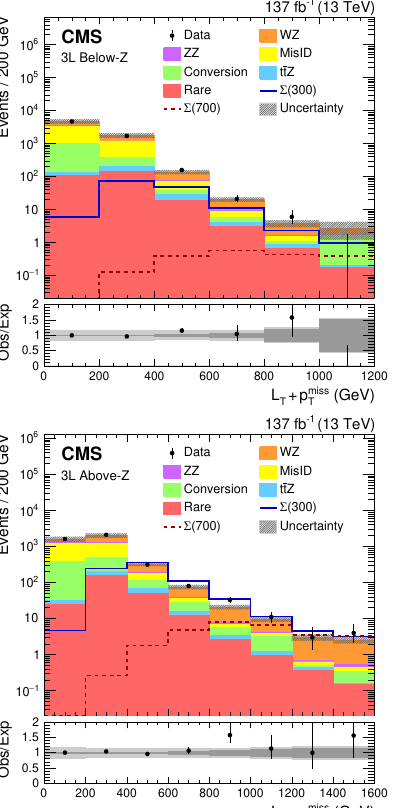
Upper limits at 95% con(cid:12)dence level (CL) are set on the product of the signal produc- tion cross sections and branching fractions using a modi(cid:12)ed frequentist approach with the CL criterion [63, 64] and the asymptotic approximation for the test statistic [65, 66]. Upper s limits at 95% CL are also set on the product of the branching fractions and the square of the scalar or pseudoscalar Yukawa coupling in the tt (cid:30) model. A binned maximum-likelihood (cid:12)t is performed to discriminate between the potential signal and the SM background pro- cesses for both signal models separately. All of the L + p miss and M bins are used for T T T the seesaw signal masses under consideration, whereas the appropriate subset of the lepton (cid:13)avor and dilepton mass bins is used for a given (cid:30) mass and branching fraction scenario in the tt (cid:30) signal model, such that the low (high) dielectron and dimuon mass spectra are considered for a light (heavy) tt (cid:30) signal with the (cid:30) ! ee and (cid:30) ! (cid:22)(cid:22) decays, respectively.